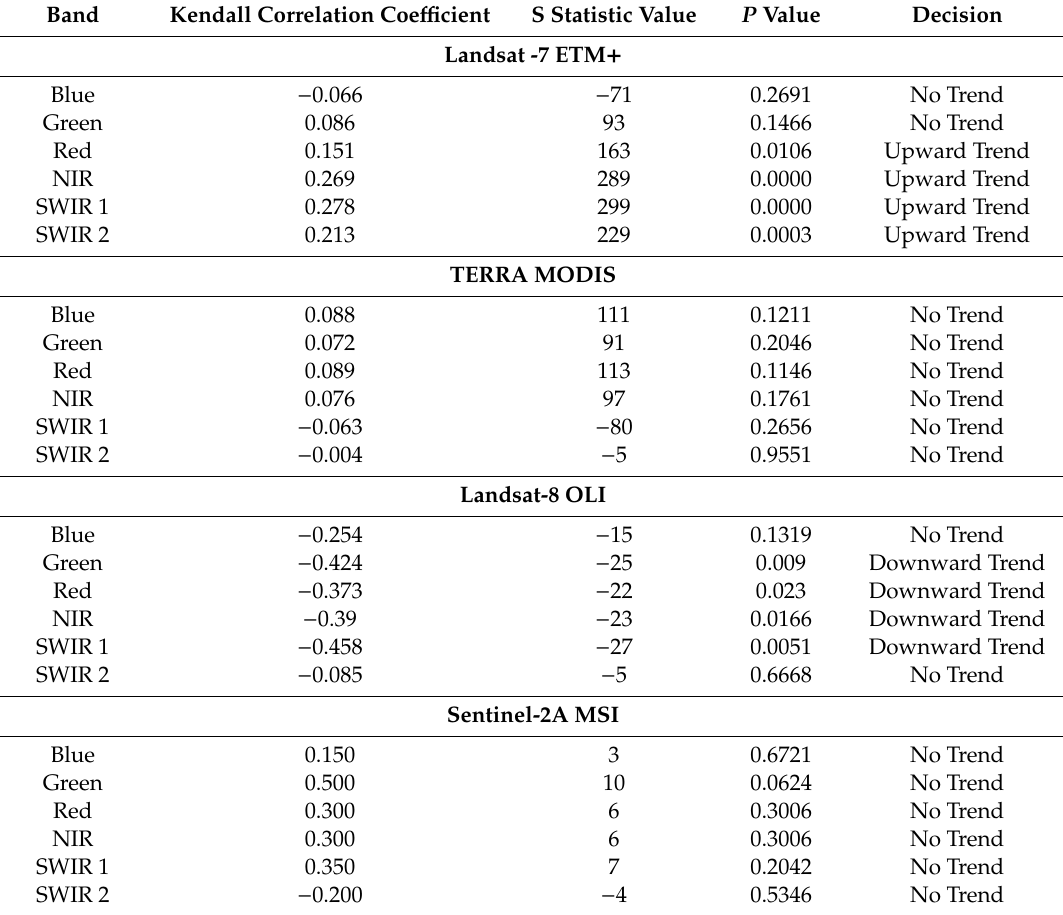
Table 7. Seasonal Mann-Kendall Test Results by Sensor for Libya 4 PICS, Significance level α =